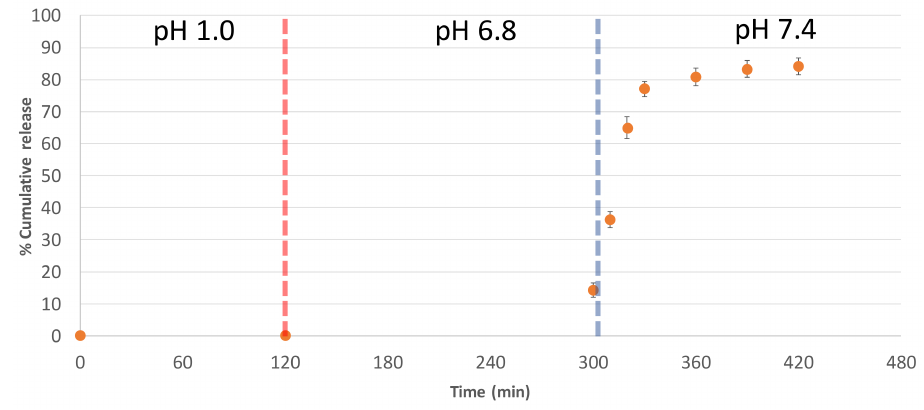
Figure 3. In vitro NPRBO release from film-coated tablets ( n = 5) in three-phase simulated gastrointestinal pH